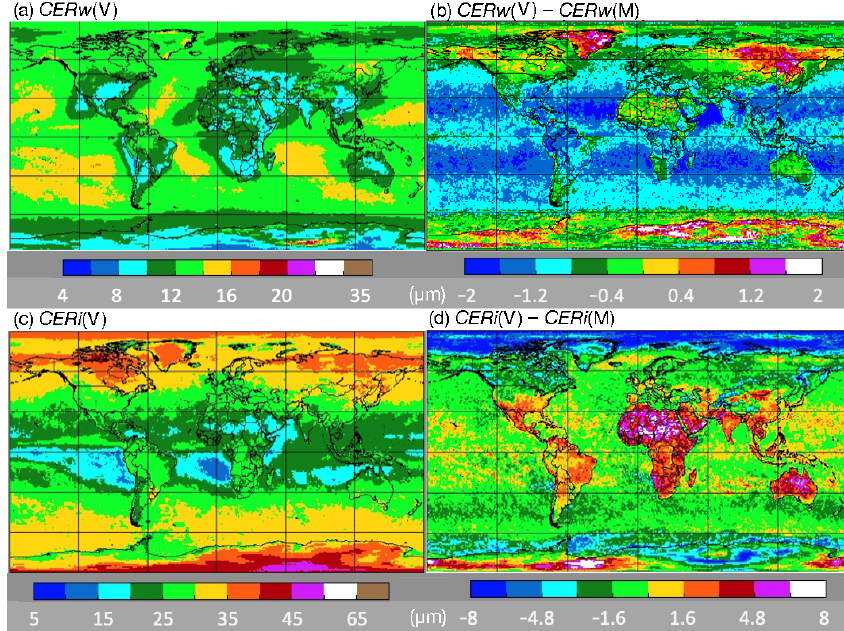
Figure 12. Same as Figure 10, except for the daytime cloud hydrometeor effective radii. Ice crystal effective radius CERi means from CV1S are plotted in Figure 12c along with the regional CERi (V) − CERi (M) differences in Figure 12d. Much like their droplet counterparts, the VIIRS CERi regional averages are distributed in patterns similar to the CM4A values with a mostly zonal decrease from the poles to the tropics (Figure 12c). Superimposed on that zonal pattern are deviations resulting from climatological circulation patterns, such as the intertropical convergence zone (e.g., ~5 ◦ N in the Pacific Ocean) and those induced by the positioning of landmasses (e.g., the west coasts of southern continents). Again, the magnitudes vary with small differences over ice-free water and large negative differences over the Arctic Ocean and parts of Antarctica and the Southern Ocean (Figure 12d). Over land equatorward of 45 ◦ latitude, CERi (V) exceeds CERi (M) by up to 6 µ m. The largest differences occur where ice clouds are sparse. The time series of nonpolar mean CER (not shown) indicate that the differences between CER (V) and CER (M) are relatively constant at − 1.1 µ m and − 0.5 µ m throughout the 9 years for water and ice clouds, respectively. For liquid clouds, the mean difference over the polar regions is much smaller than that over the nonpolar regions. A slight upward trend, evident in CERw (V) and CERw (M), is primarily due to clouds over nonpolar areas (not shown). Table 6 lists the CER averages from Aqua CM4A and CV1S for 2012–2020. Overall, the CERw (V) and CERi (V) means are 1.1 and 0.8 µ m less than those from Aqua, respectively. These global differences are mainly driven by clouds over the nonpolar oceans where the VIIRS CERw and CERi means are 1.2 µ m and 0.9 µ m, respectively; smaller than the CM4A averages. Over the polar regions, the mean CERi (V) is 1.8 µ m less than CERi (M); it exceeds CERi (M) by 0.8 µ m over nonpolar